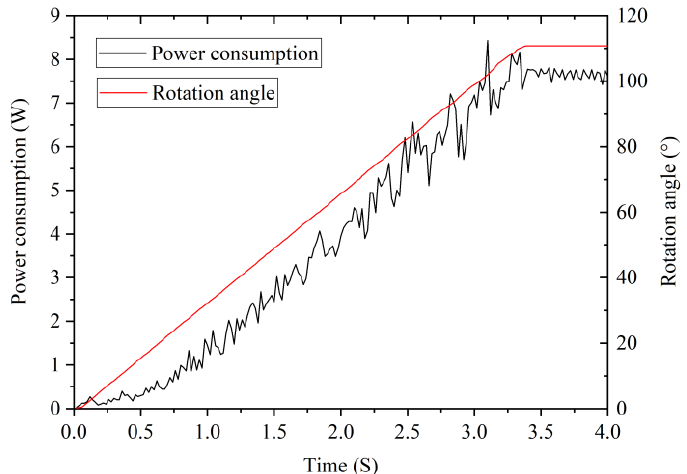
Figure 8. The change of power consumption and rotation angle of elbow actuator in the test of lifting 200 g external load.